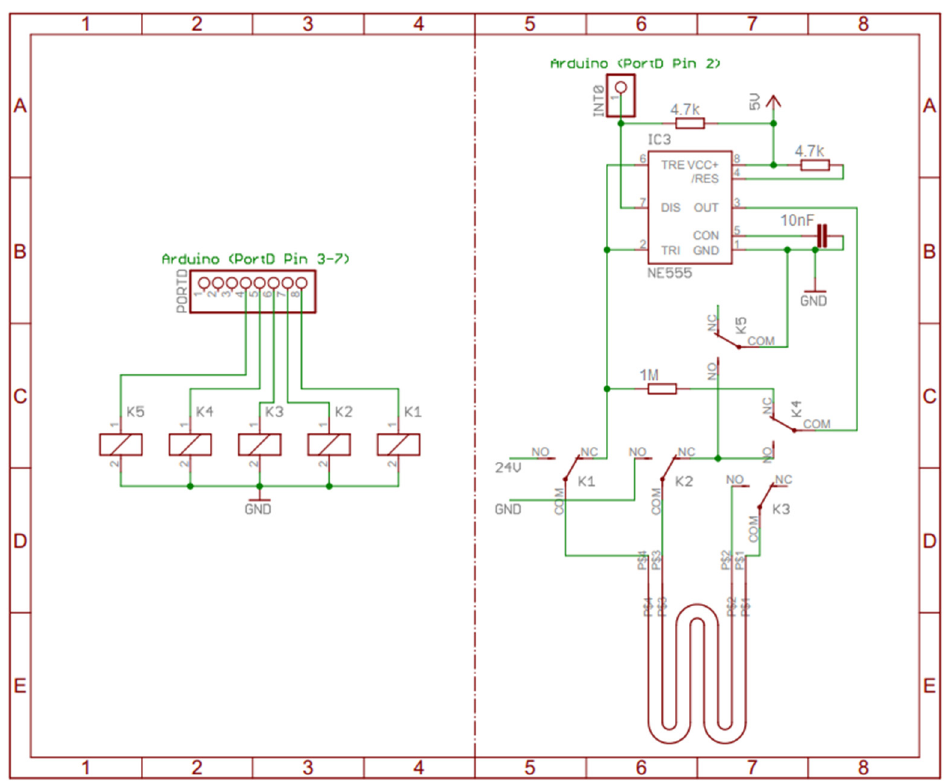
Figure A1. Schematic of the used time-to-digital-conversion-circuit for capacitance-measurement based on an Arduino Uno described in Section 2.5. Two Modes of Operation are to be differed: (1) Heating the CSS, for higher ohmic resistance both tracks are switched in row—K1/K2/K3 switched to NO, K4/K5 switched to NC. (2) Measuring the capacitance of the CSS by charging it with a 1 MOhm Resistor—K1/K2/K3 switched to NC, K4/K5 switched to NO.